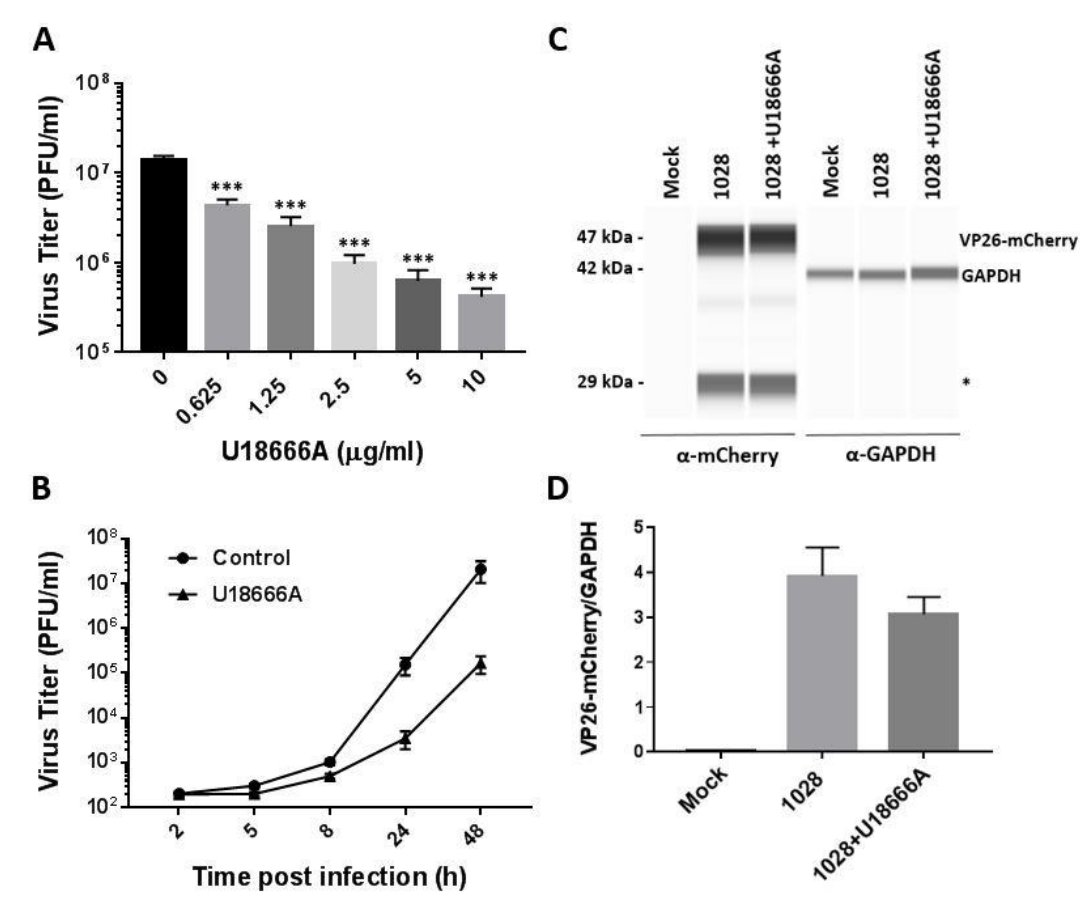
Figure 5. Effects of U18666A on PRV1028 production and protein expression. ( A ) PK-15 cells were infected with PRV1028, a recombinant PRV expressing a carboxy-terminal VP26-mCherry fusion, at an MOI of 5 in the presence of U18666A (0.625–10 µ g/mL) or DMSO (0.1%, v / v ) as a control. At 48 h post-infection, virus titer in the culture supernatant was measured by plaque assay. Virus titer is presented in plaque-forming units (PFU)/mL. Data are mean ± SD ( n = 3). *** p < 0.001. ( B ) PK-15 cells were infected with PRV 1028 at an MOI of 5 in the presence of U18666A (5 µ g/mL) or DMSO (0.1%, v / v ) as a control. At the indicated times post-infection, virus titer in the culture supernatant was measured by plaque assay. Data are mean ± SD ( n = 3). ( C ) Effects of U18666A on the PRV 1028 VP26-mCherry protein expression. PK-15 cells were infected with PRV 1028 (MOI = 5) in the presence of U18666A (5 µ g/mL) or DMSO (0.1%, v / v ) as a control. Cell extracts were harvested at 24 h post-infection and subjected to WES protein analysis (ProteinSimple, San Jose, CA, USA) using rabbit anti-mCherry antibody (Abcam ab183628). Probing with anti-GAPDH antibody (Cell Signaling #5174) was included as a loading control. A mock-infected sample was included as a negative control. The asterisk (*) indicates the position of the degradation product from VP26-mCherry. A full image of WES protein analysis can be found in Supplementary Materials. Data are representative of three independent experiments. ( D ) The intensity of protein bands for VP26-mCherry and GAPDH was quantitated using the WES protein analysis software (ProteinSimple), and the ratio of VP26- mCherry/GAPDH was determined. Data are mean ± SD ( n = 3) from three replicate runs in a representative